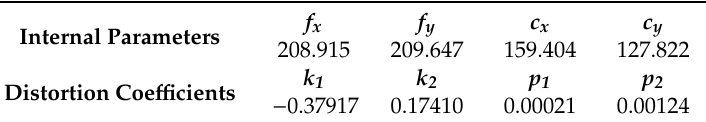
Figure 10. Results of lens distortion correction. ( a ) Before calibration and ( b ) after calibration. The internal parameters and the distortion coefficients are shown in Table 2. Table 2. Lens parameters.